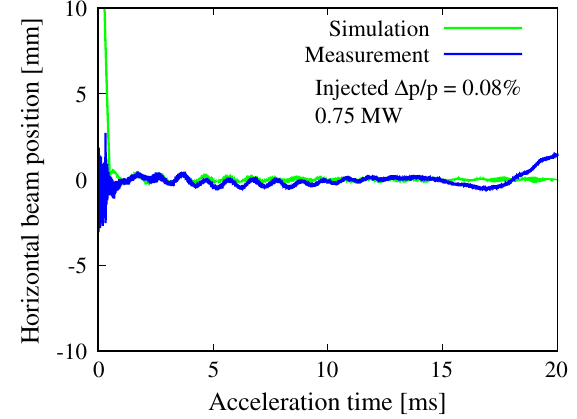
FIG. 21. Demonstration of beam instability suppression in the simulation (green) as well as in measurement (blue) by using a narrower momentum spread Δ p / p ¼ 0.08% (rms) in the injected